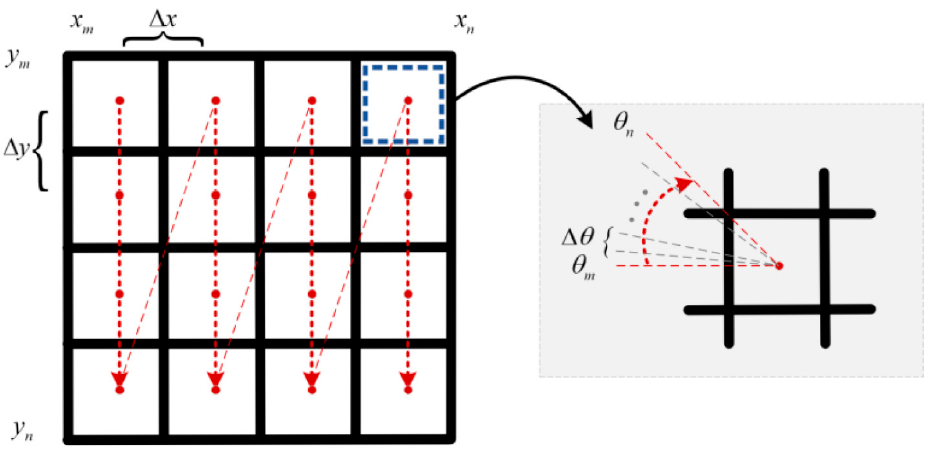
Figure 2. Search space for scan matching in CSM algorithm.